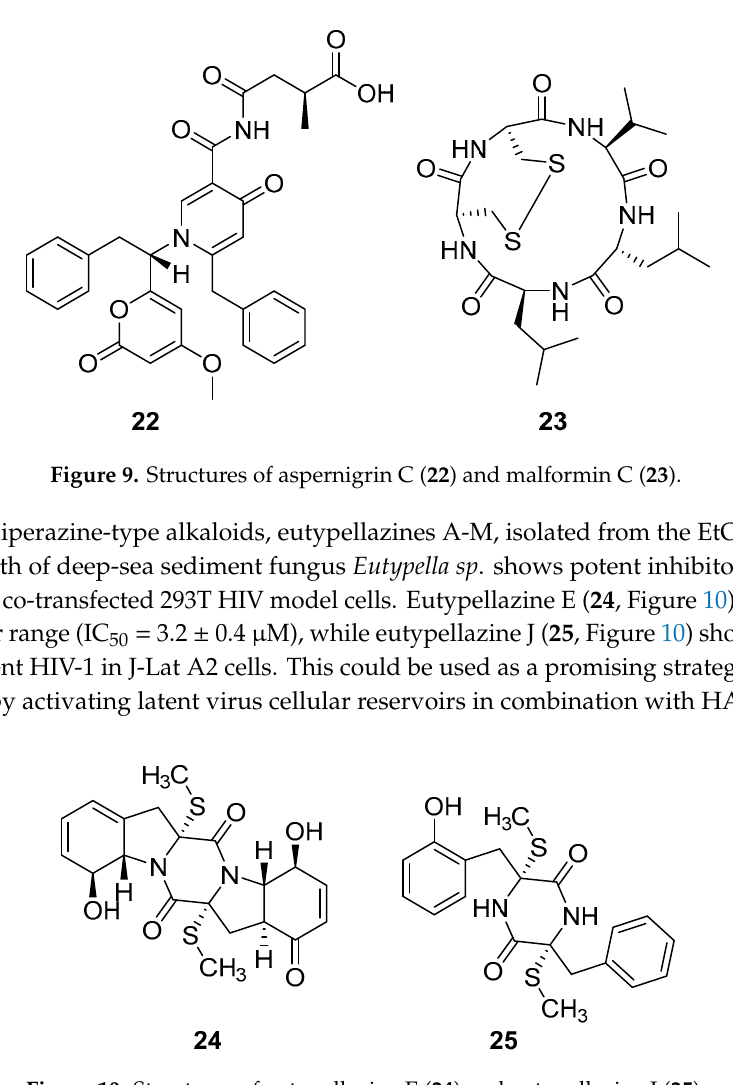
Figure 10. Structures of eutypellazine E ( 24 ) and eutypellazine J ( 25 ).